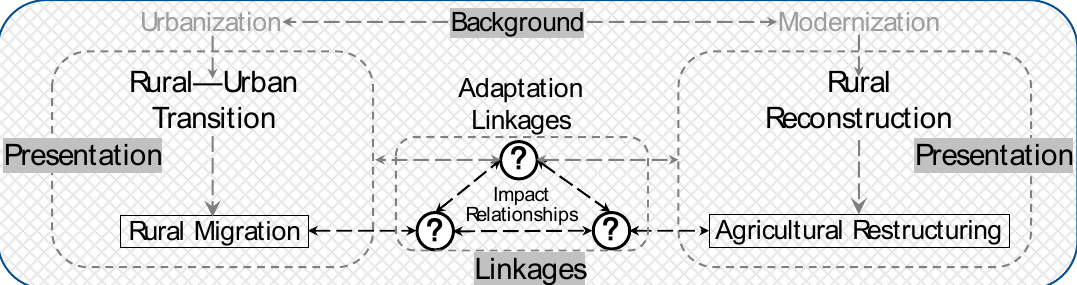
Figure 1. Theoretical framework and research design.